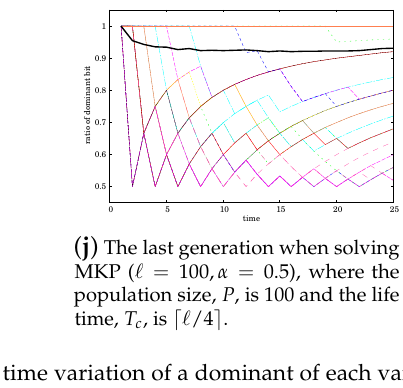
Figure 8. Examples of the time variation of a dominant of each variable, 0 or 1, in the development of an individual at the first and the last generations. The black bold line in each figure represents the average of the ratios of all